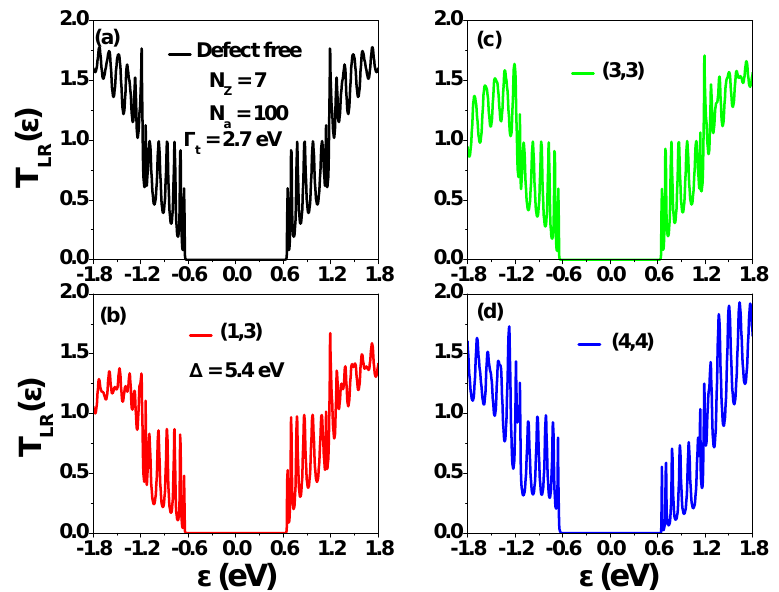
Figure 7. Transmission coefficient of AGNRs as a function of ε for Γ t = 2.7 eV, N z = 7, and N a = 100 ( L a = 10.5 nm) with ( a ) no defect, ( b ) a defect at site (1,3), ( c ) a defect at site (3,3), and ( d ) a defect at site (4,4). The energy shift at a defect site adopted is ∆ = 5.4